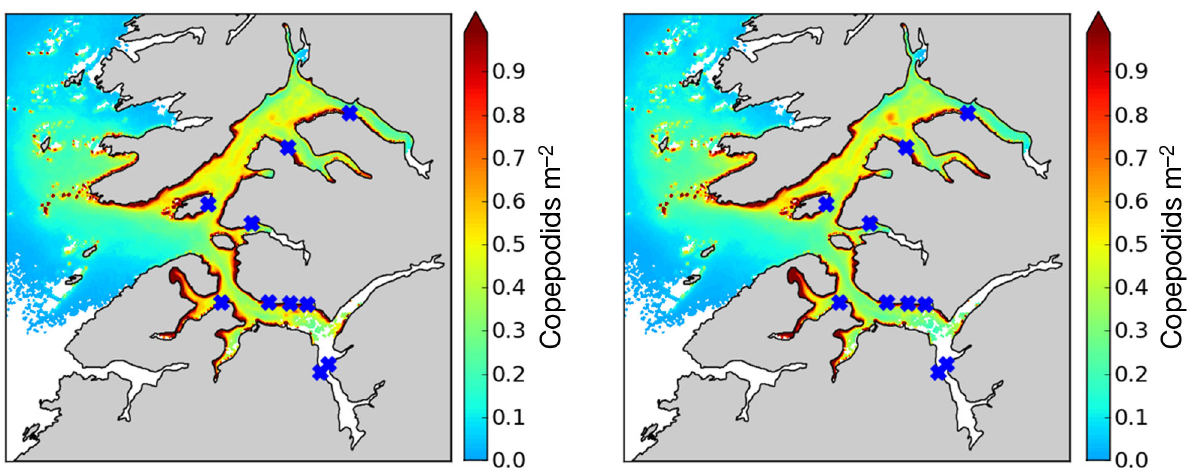
Fig. 6. Normalized horizontal distribution of salmon lice Lepeophtheirus salmonis copepodids from simulation with no mortality (right) and mortality of 0.17% d −1 (left) during nauplii and copepodid stages. All sources release the same number of